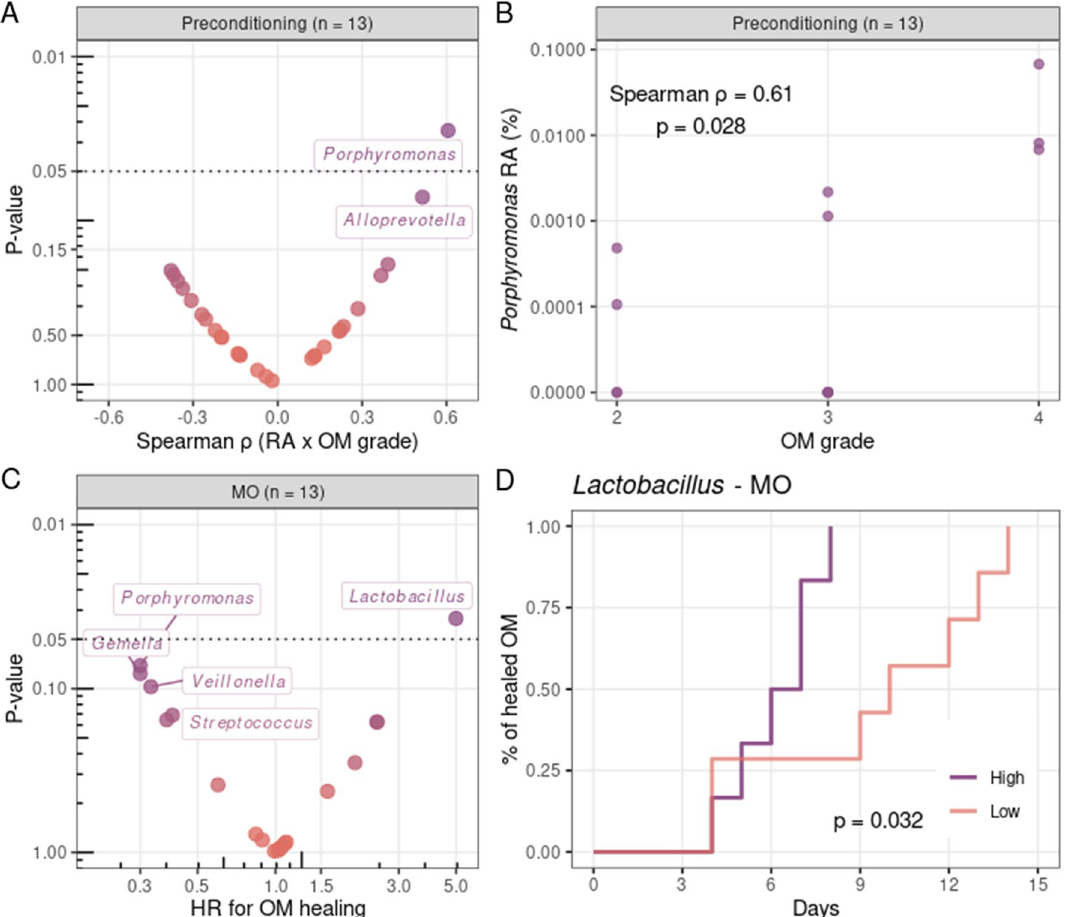
Figure 4. Genera associated with oral mucositis (OM) grade and OM healing. ( A ) Volcano plot (Spearman ρ vs. P-value) depicting correlations between the highest OM grade and genera relative abundances at preconditioning (P). ( B ) Spearman correlation between the highest OM grade and Porphyromonas relative abundance at P. Spearman ρ and P-value are indicated. RA relative abundance. ( C ) Volcano plot (Cox hazard ratio vs. P-value) of the risk analysis for the association of OM healing with genera relative abundance at OM onset (MO). ( D ) Cumulative incidence curves of healed OM with patients stratified by Lactobacillus relative abundance (low/high, based on median value) at MO. Statistical significance was evaluated by the log-rank test, with P-value indicated. In ( A,C ), only genera present (non-zero relative abundance) in > 50% of the samples were evaluated. Only genera with P-value < 0.15 are indicated